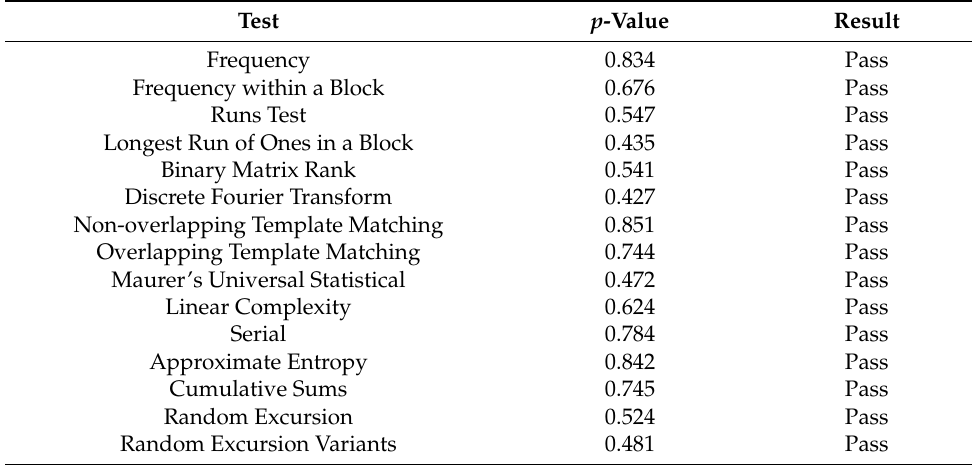
Figure 6. Distribution of inter-HD and intra-HD of 32-bit responses. Table 1. Summary table of NIST test